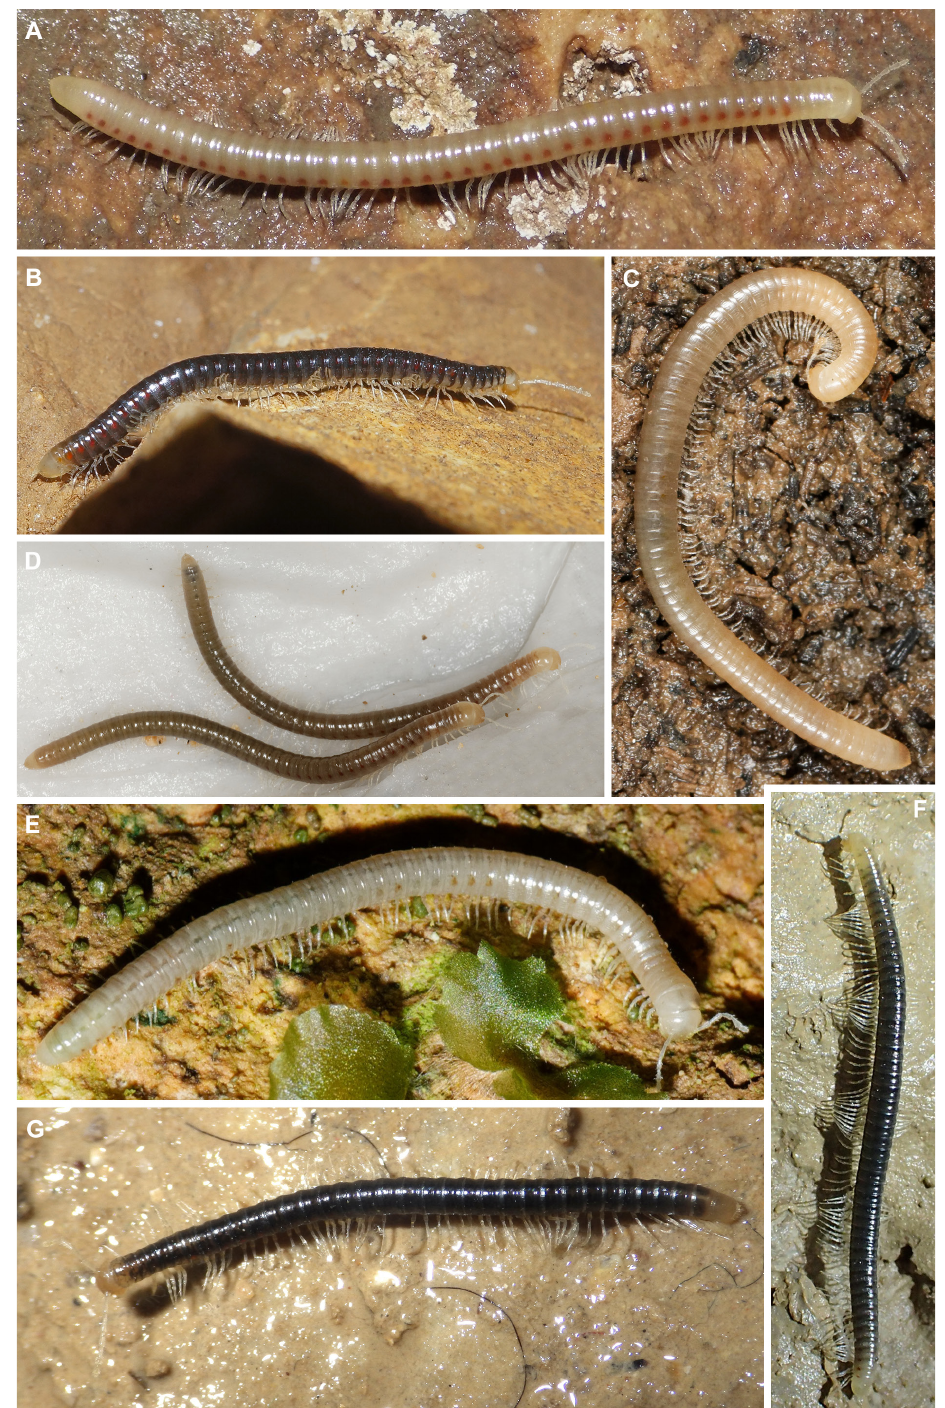
Fig. 1. Leucogeorgia Verhoeff, 1930 species in situ . A . L. abchasica (Lohmander, 1936) comb. nov., ♂ from Abraskila Cave (photo: Ilya Turbanov). B . L. caudata sp. nov., type ♂ from Novoafonskaya Cave (photo: Olga Chervyatsova). C . L. gioi sp. nov., paratype ♀ (SMNG) (photo: Hans Reip). D . L. lobata sp. nov., specimens from Motena Cave (photo: Hans Reip). E . L. prometheus sp. nov., specimen from Prometheus Cave (photo: Hans Reip). F . L. profunda sp. nov., non-type ♀ from Veryovkina Cave (photo: Sergei Ivanov). G . L. turbanovi sp. nov., non-type ♂ from Krubera Cave (photo: Ilya